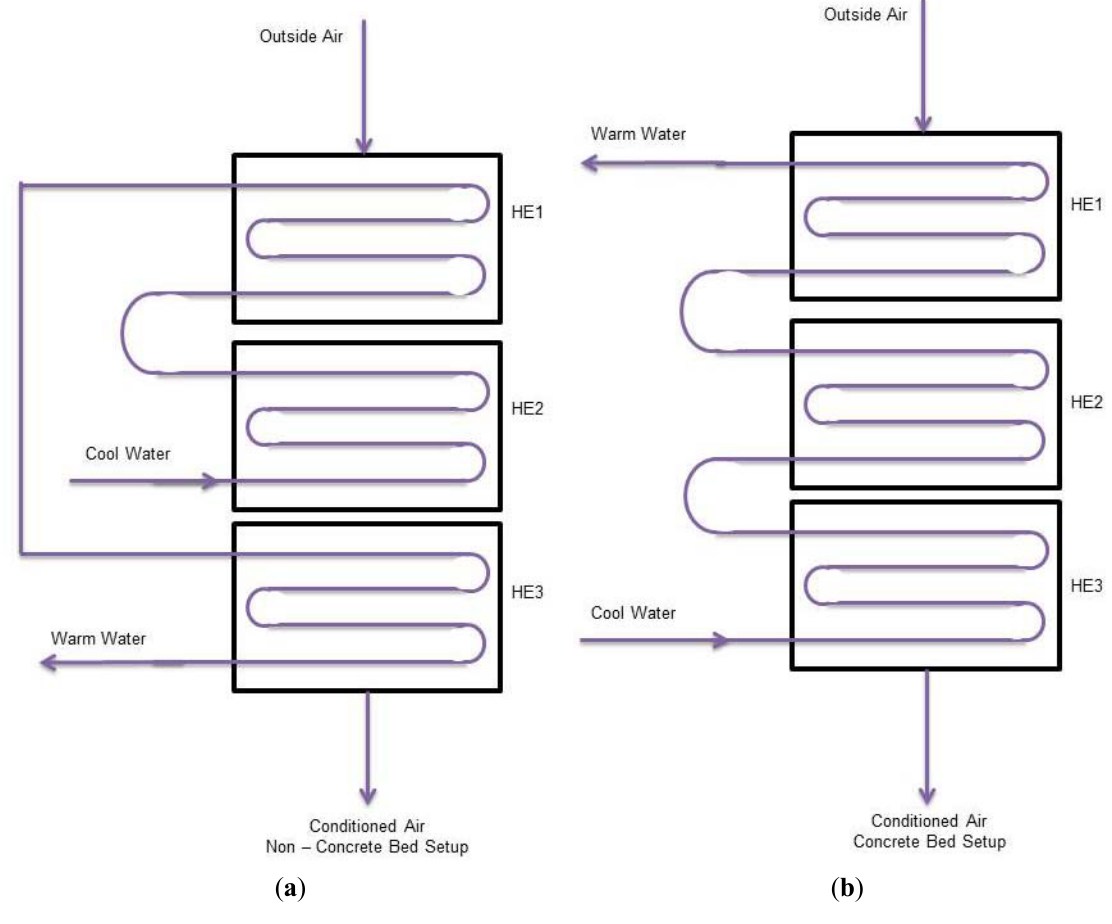
Figure 11. Arrangement of the heat exchanger in the decentralized units. ( a ) Arrangement A; ( b ) Arrangement B